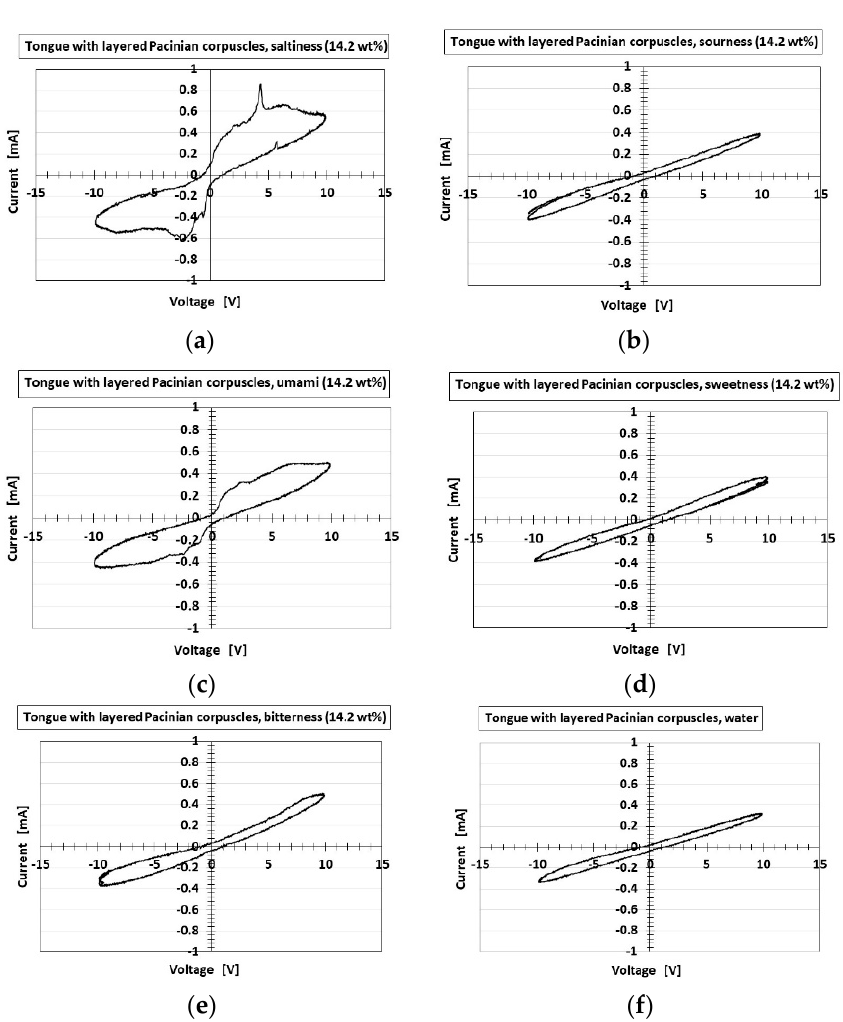
Figure 17. Experimental results of cyclic voltammogram plots for layered Pacinian corpuscles responding to: ( a ) saltiness; ( b ) sourness; ( c ) umami; ( d ) sweetness; ( e ) bitterness; ( f ) water.